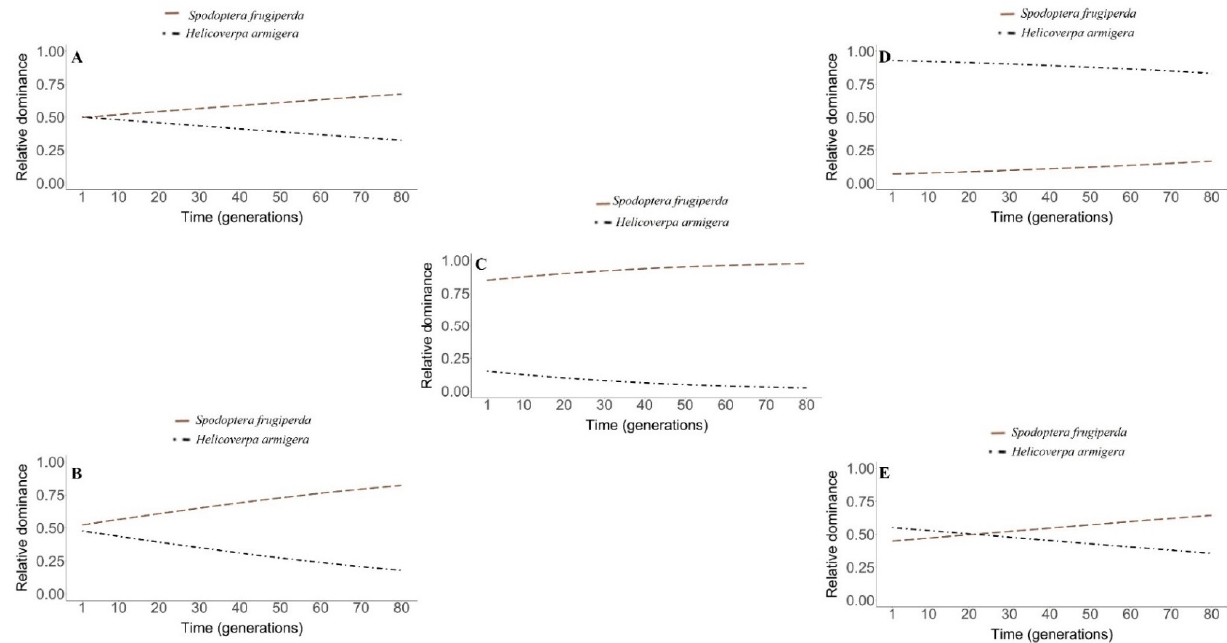
Figure 4. Dynamics of temporal evolution of the ecological dominance of S. frugiperda (light salmon long dashed line) and H. armigera (black dotted line) in the following conditions: ( A ): absence of insecticide control. ( B ): insecticide control and absence of cases of insecticide resistance. ( C ): insecticide control and resistance of S. frugiperda to the insecticide. ( D ): insecticide control and resistance of H. armigera to the insecticide. ( E ): insecticide control and resistance of S. frugiperda and H. armigera to the insecticide. (For a color version of this figure, the reader is referred to the web version of this article.)